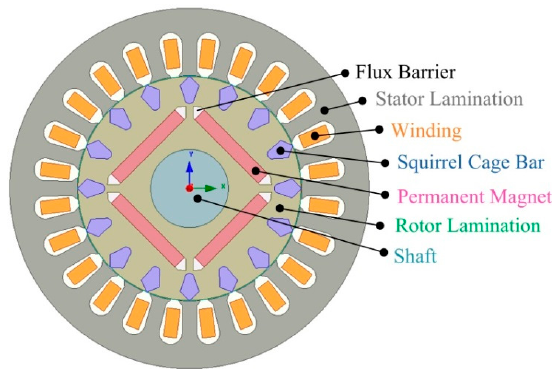
Figure 1. The structure of three phase line start permanent magnet synchronous motors LS-PMSM (four pole).